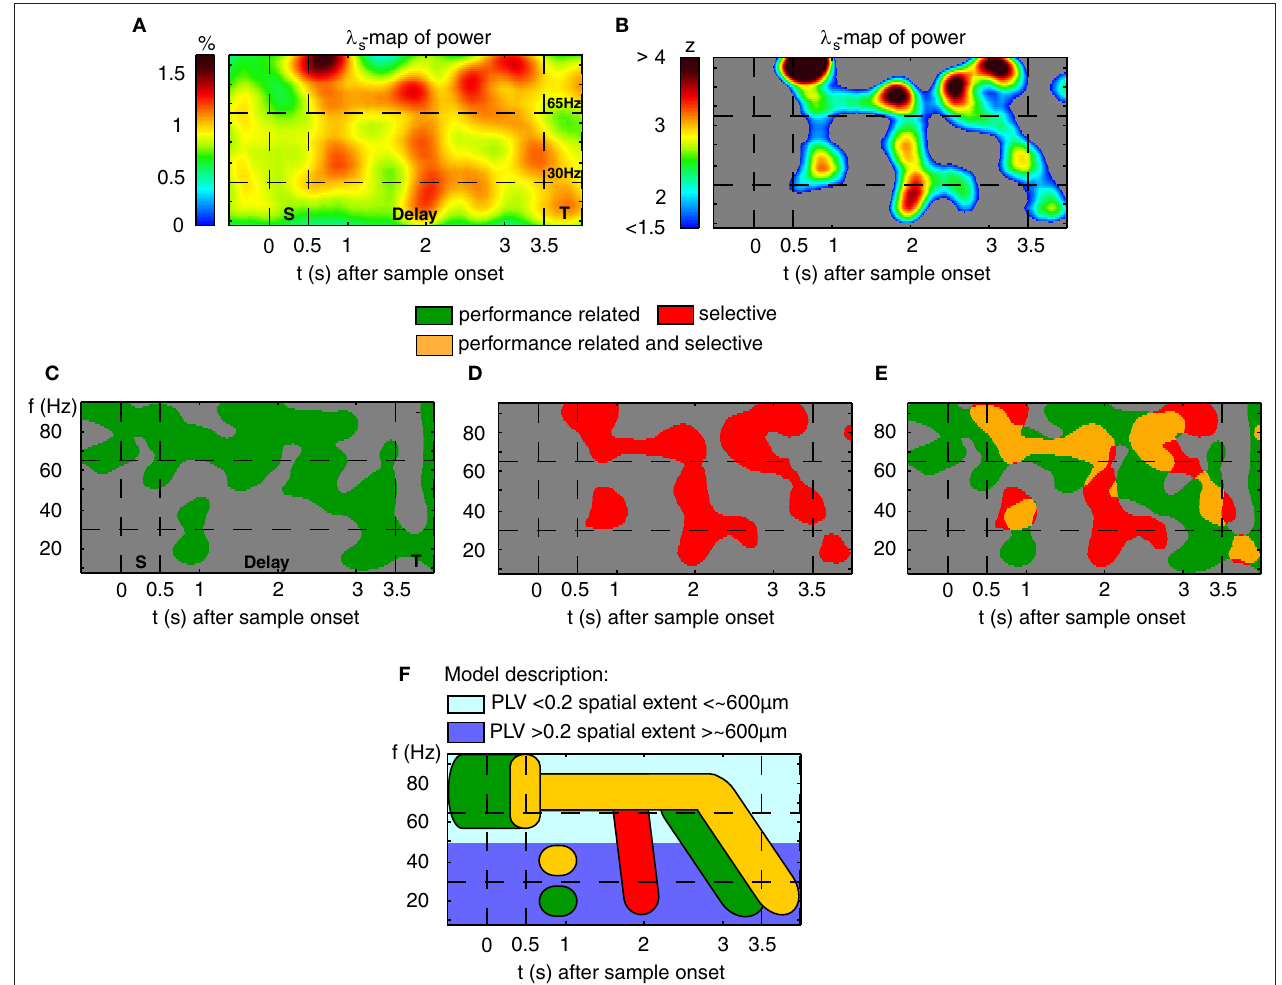
FIGURE 5 | Stimulus-selective and performance-dependent increases of ß- and γ -oscillations in prefrontal fi eld potentials. (A) Time-frequency λ s-map averaged across data from two monkeys (7 Sessions, 4040 Trials, and 94 Sites). Abscissa and ordinate represent peri-stimulus time aligned to the onset of sample stimuli and signal frequency, respectively. Color codes provide the percentage of sites with signifi cant differences in power across different stimuli (‘S’, ‘T’: Sample and Test stimulus presentation). (B) Modulations of the λ expressed as z -score in respect to baseline ( − 0.5–0 s). (C)